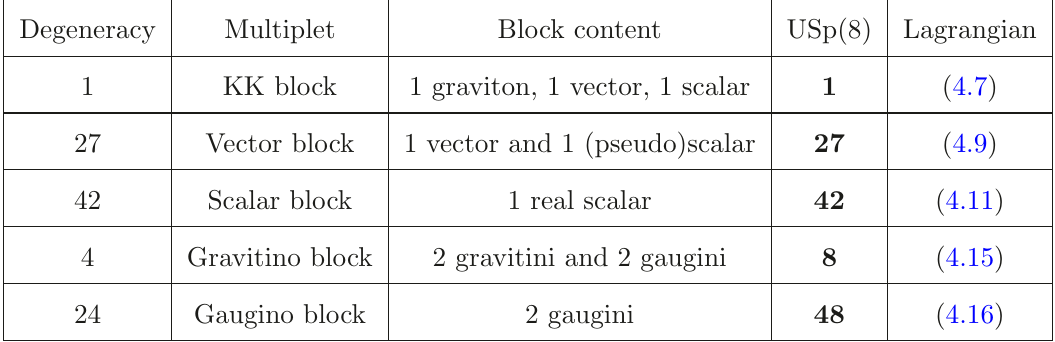
Table 3 . Decoupled quadratic fluctuations in